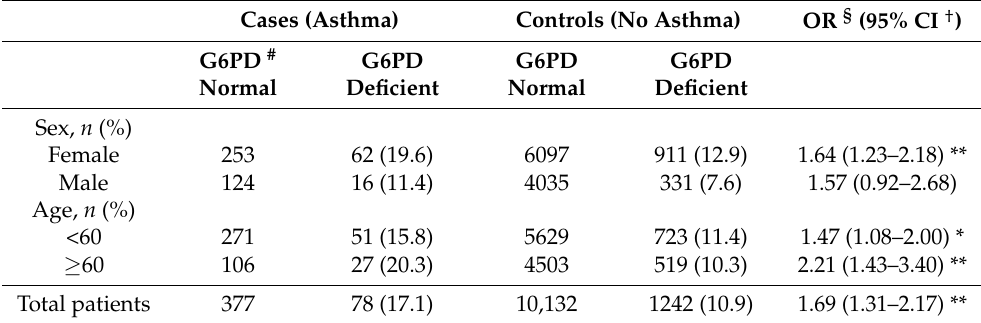
Table 2. Risk of asthma according to sex and age in G6PD-normal and -deficient individuals. Cases (asthma)